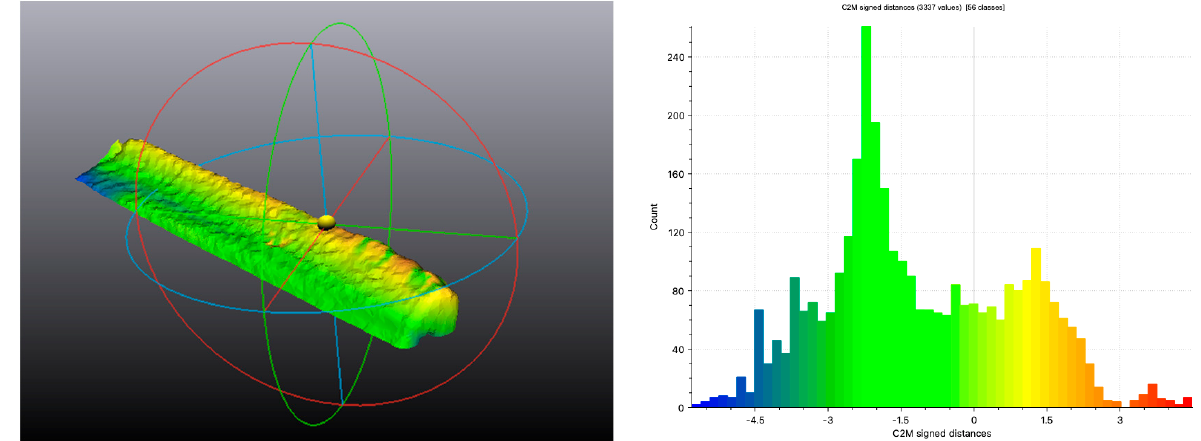
Figure 8. Surface overlap between FCSpost-op and FCSplan and colorimetric map obtained from the surface comparison. The X-axis shows the signed discrepancy in mm, while the Y-axis shows the number of points.